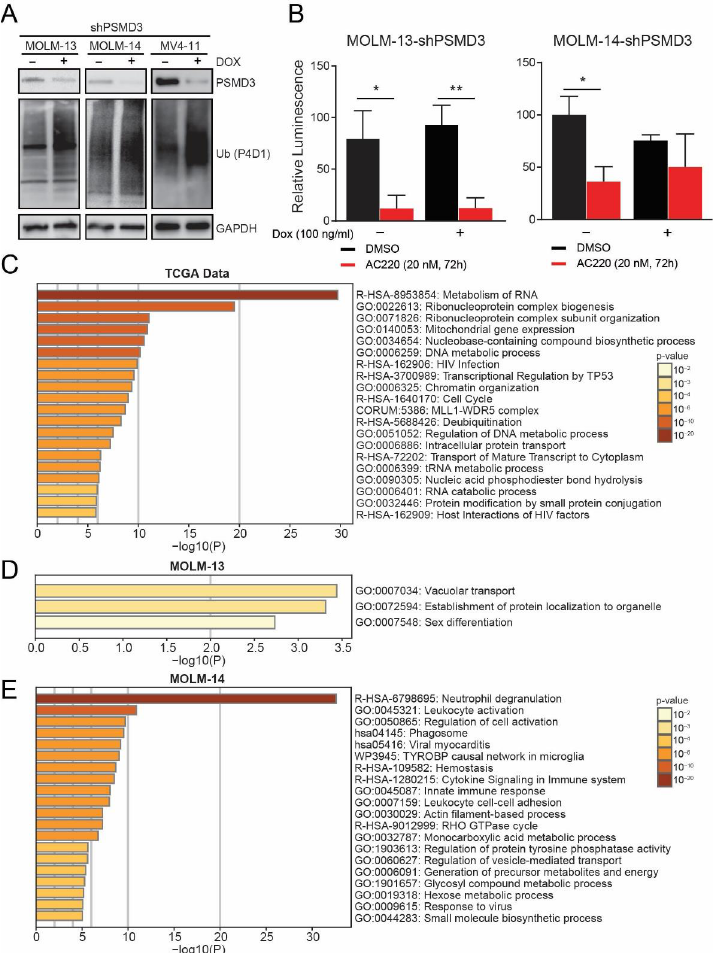
Figure 4. PSMD3 knockdown in FLT3+ AML increased global ubiquitylated proteins, but had little effect on NF- κB luciferase reporter activity. ( A ) Immunoblot shows the effect of PSMD3 knockdown (shPSMD3) on global protein ubiquitylation in MOLM-13, MOLM-14, and MV4-11 cells. GAPDH levels were measured as a control. ( B ) Bar graphs show the effect of PSMD3 knockdown combined with the FLT3 TKI, quizartinib (AC220, 20 nM, 72 h), on NF- κB luciferase reporter activity in MOLM-13 ( left ) and MOLM-14 ( right ) cells. Error bars represent SEM (* p < 0.05; ** p < 0.01). ( C ) Bar graph shows pathway enrichment analysis of the gene sets upregulated with PSMD3 expression in AML data from The Cancer Genome Atlas (TCGA) available at UALCAN (http://ualcan/path.uab.edu/, accessed on 30 July 2021). ( D , E ) Bar graphs show pathway enrichment analysis of the proteins that were dysregulated upon shRNA-mediated PSMD3 knockdown in the MOLM-13 ( D ) and MOLM-14 ( E ) AML cell lines, as measured by mass spectrometry-based proteomics analyses. The darkness of the orange color reflects the p -value, with darker colors having greater significance.